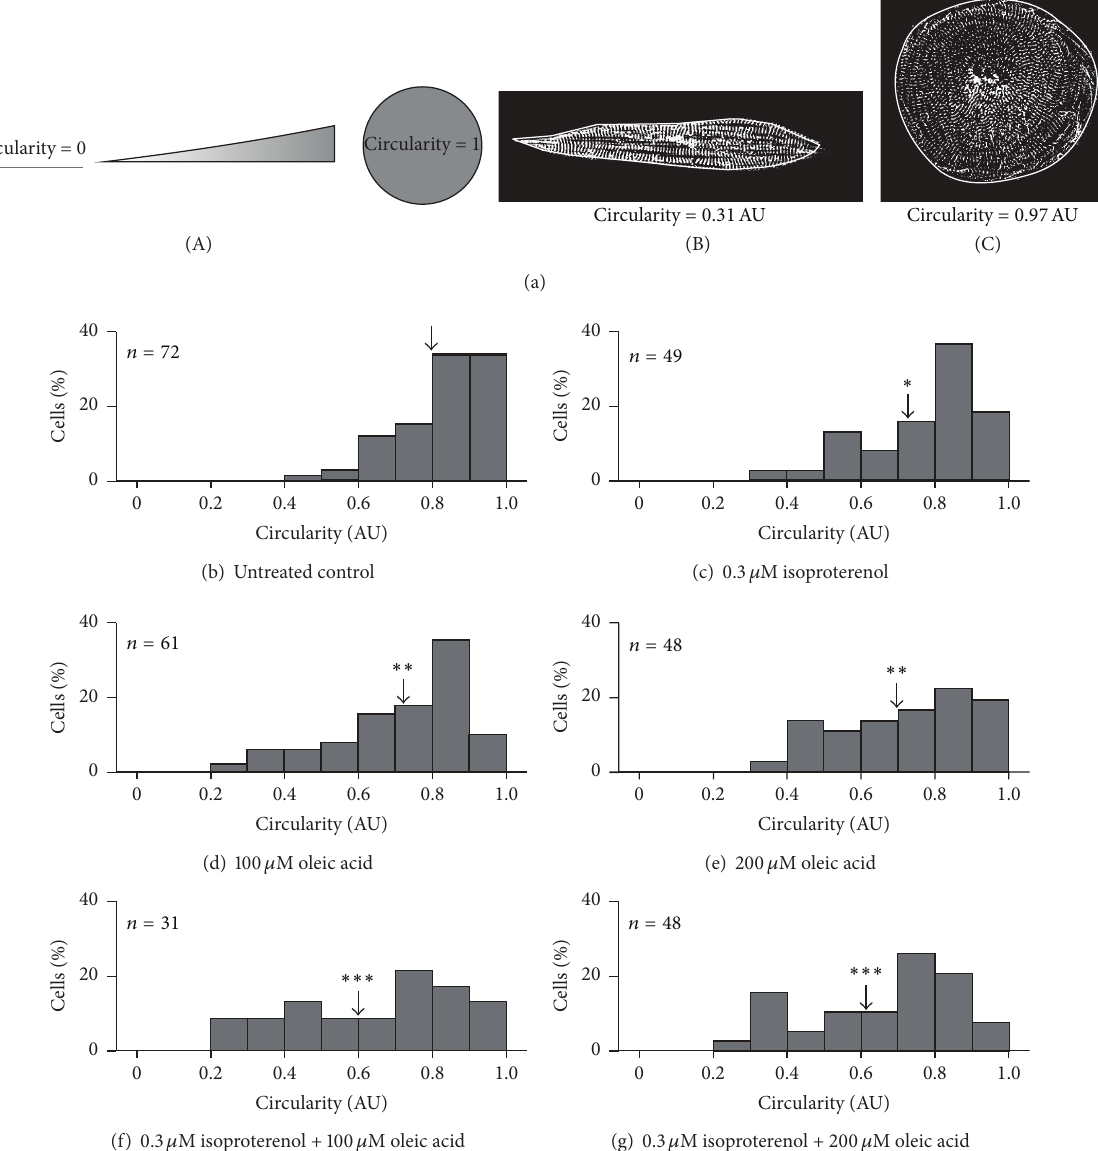
Figure 1: Effect of isoproterenol and oleic acid on the shape of hESC-vCMs. ((a) panel (A)) Schematic illustration to show that circularity values of 0 and 1 represent a straight line and perfect circle, respectively. ((a) panel (B), (a) panel (C)) Representative examples of elongated and rounded hESC-vCMs (labeled with an 𝛼 -actinin antibody) that have circularity values of ((a) panel (B)) 0.31AU and ((a) panel (C)) 0.97 AU, respectively. Scale bar is 30 𝜇 m. (b–g) Histograms to show the distribution of cells (in %) exhibiting a particular circularity value in (b) untreated controls and (c–g) following treatment with (c) 0.3 𝜇 M isoproterenol, (d) 100 𝜇 M oleic acid, (e) 200 𝜇 M oleic acid, (f) 0.3 𝜇 M isoproterenol plus 100 𝜇 M oleic acid, or (g) 0.3 𝜇 M isoproterenol plus 200 𝜇 M oleic acid. The number of cells analyzed is indicated in the upper left corner of each graph. The arrows indicate the mean circularity value determined for the population of cells, and the asterisks indicate values that are significantly different from the untreated control at ∗ 𝑝 ≤ 0.05 ; ∗∗ 𝑝 ≤ 0.01 ; and ∗∗∗ 𝑝 ≤ 0.001